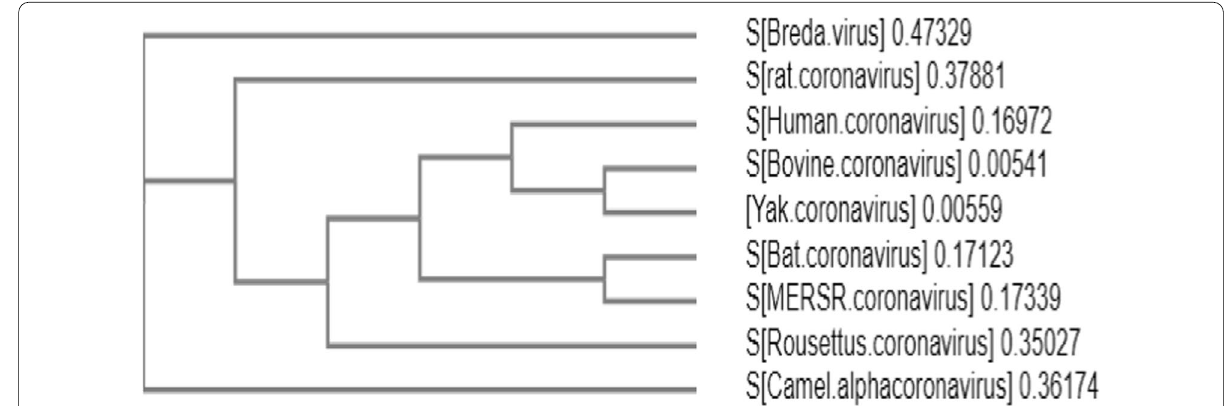
Fig. 3 Spike glycoprotein protein-based phylogenetic analysis of